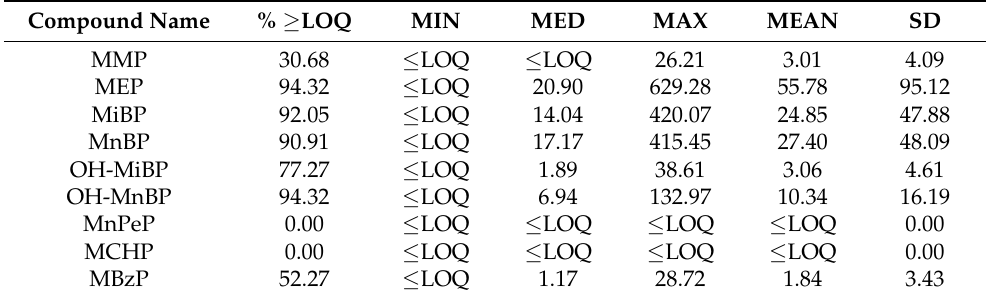
Table 2. Descriptive statistics of phthalate metabolite concentrations